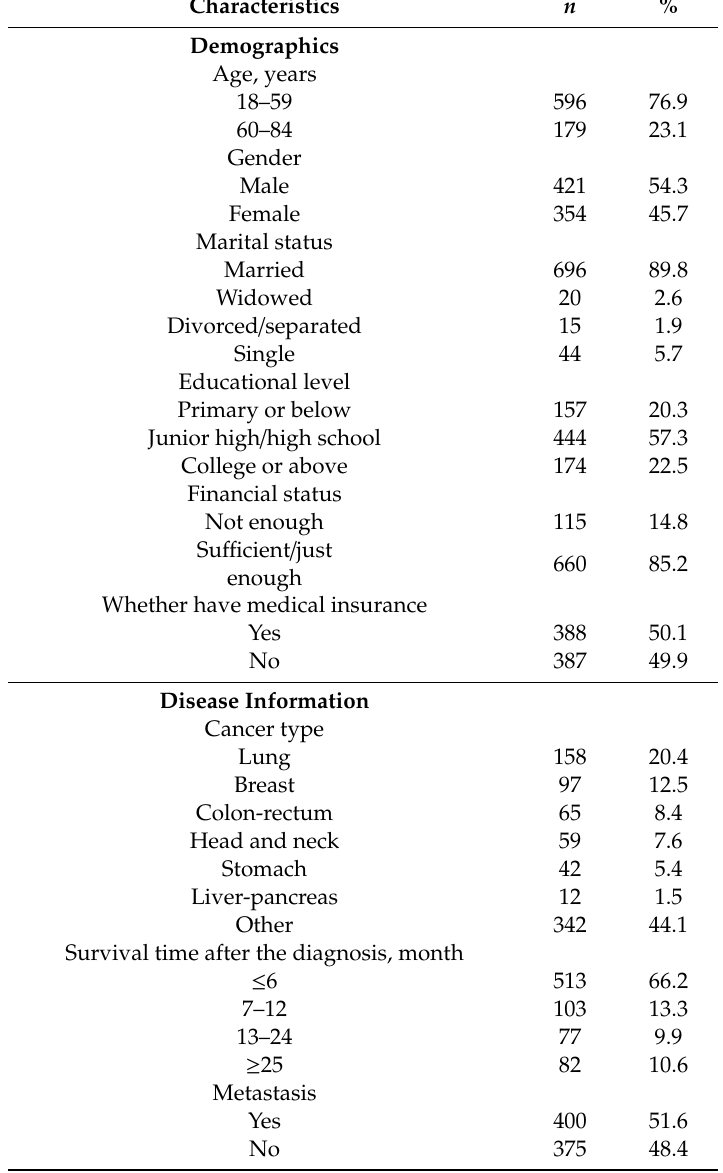
Table 1. Participants’ demographic and health status characteristics ( n =